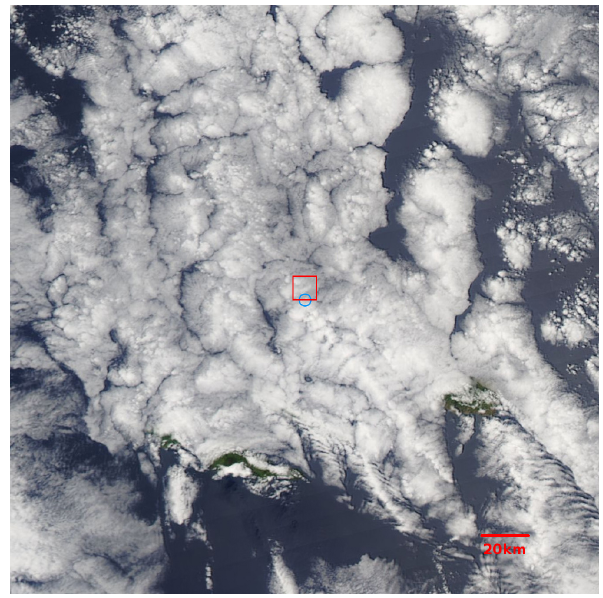
Figure 3. As in Fig. 1 but taken on 18 July 2017 at 14:43UTC (shortly before flight no. 14). The image was acquired from NASA Worldview Snapshots.